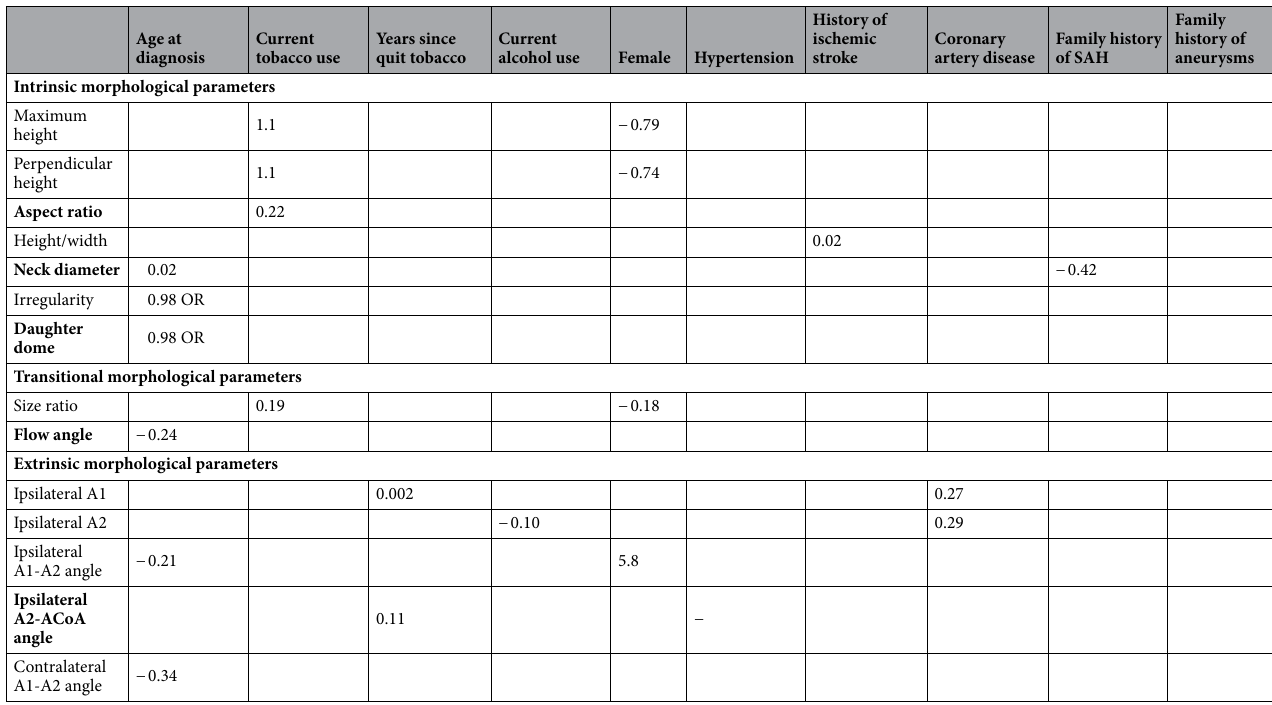
Table 3. Multivariate analyses of morphological characteristics. Regression coefficients or odds ratios (OR) of significant factors are shown. Morphological characteristics significantly associated with rupture in multivariate analysis are bolded. See Supplemental Tables for complete results. ACoA anterior communicating artery.